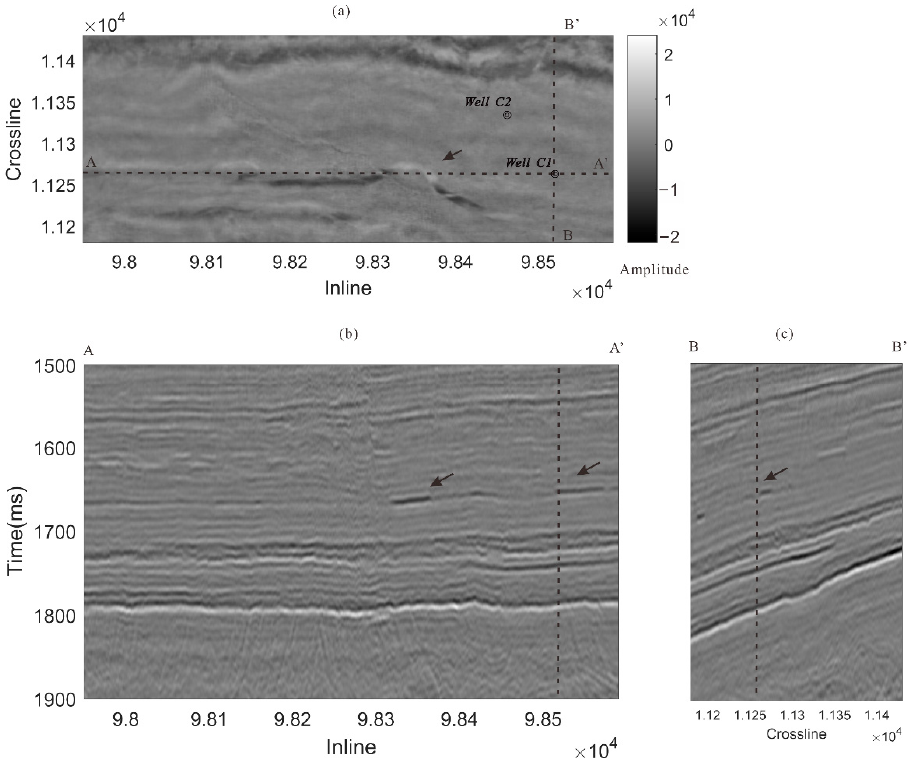
Figure 4. The location of wellbore and the through-well seismic profiles. ( a ) The time slice at t = 1650 ms; ( b ) the vertical seismic profile extracted at Crossline No. 98520; ( c ) the vertical seismic profile extracted at Crossline No. 11272. The dotted lines indicate the location of the through-well seismic profiles.